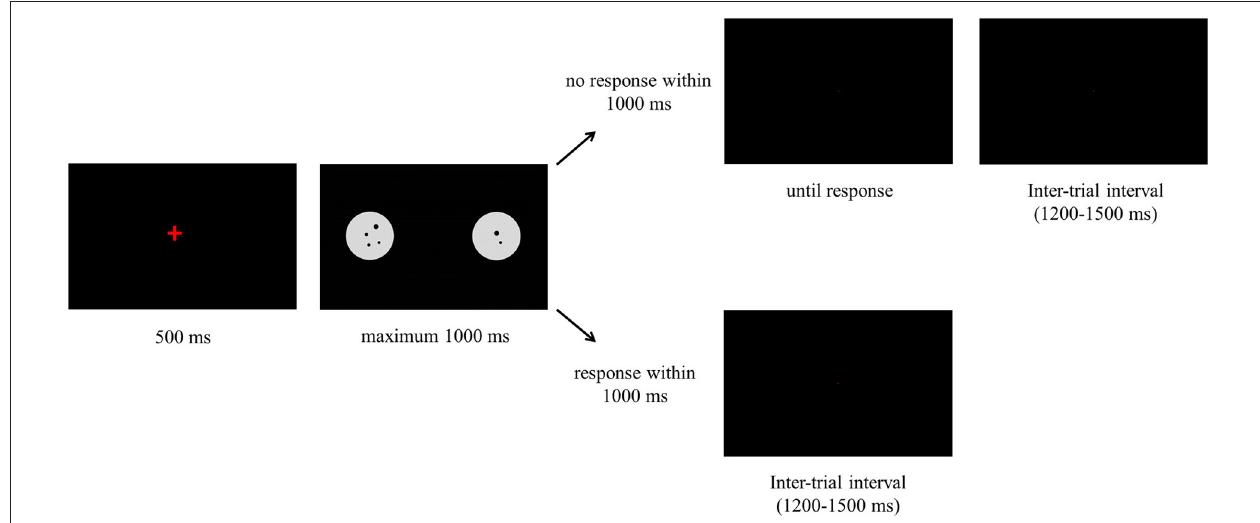
FIGURE 1 | Presentation of the stimuli in one trial for the comparison and same-different